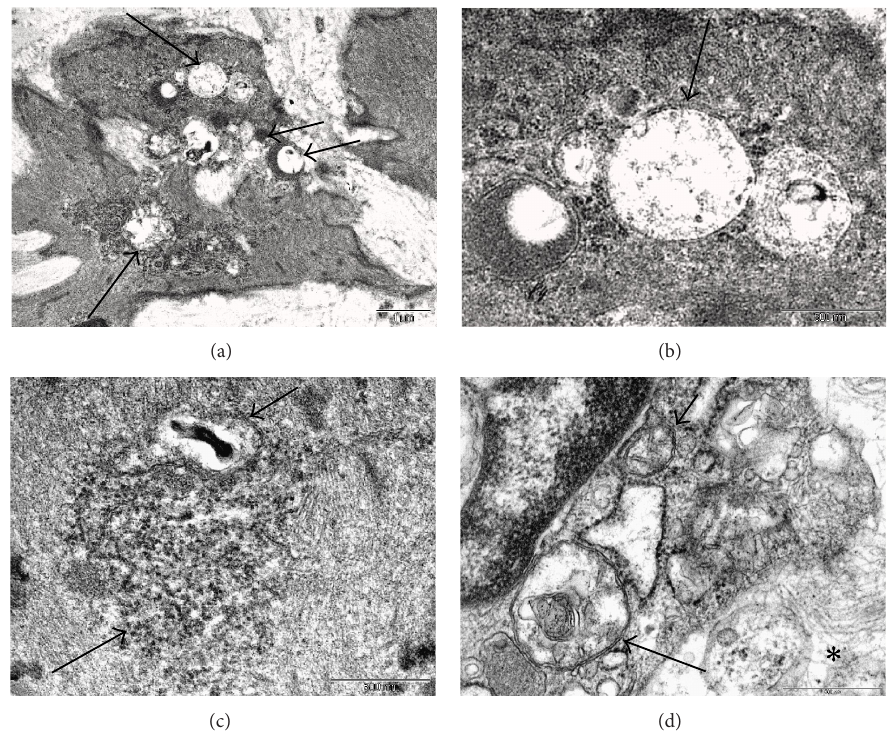
Figure 13: Lysosomes and Autophagy. The myocyte in (a) contains several vacuoles (long arrow at top and left lower) and lysosomes (shorter, horizontal arrows in middle). Higher magnification of the 4 structures at the top of the cell in (b) shows partial fusion of vacuoles to form a double membraned autophagosome in the middle (arrow). Granular debris in the vacuolar lumens may represent degenerate myofilament particles. The image in (c) shows degenerate myofilaments in the center (long arrow) and an autophagic vacuole (short arrow) which appears to be engulfing the degenerate filaments. The myofilaments on either side of this central area appear to be intact. The cell in (d) exhibits more advanced changes with loosely expanded cytoplasm separating the myofilaments on the right (asterisk), degenerating and swollen mitochondria (short arrow), and an autophagosome with membranous and particulate debris (long arrow). Original magnification of (a): 11,500x. Original magnification of (b), (c), and (d):